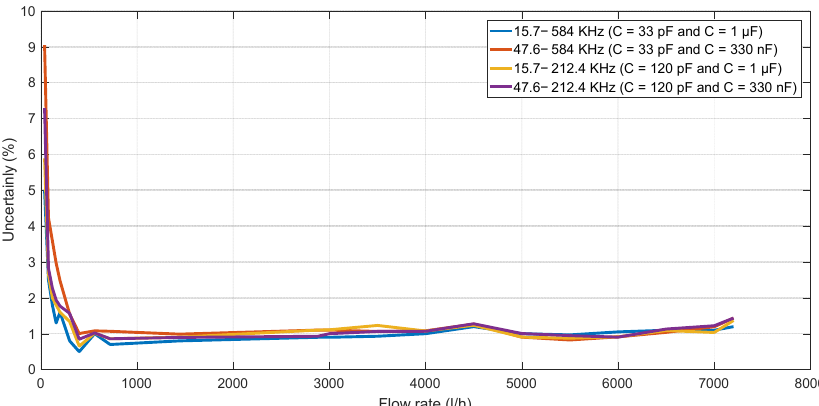
Figure 23. Uncertainty achieved with different filtering options.